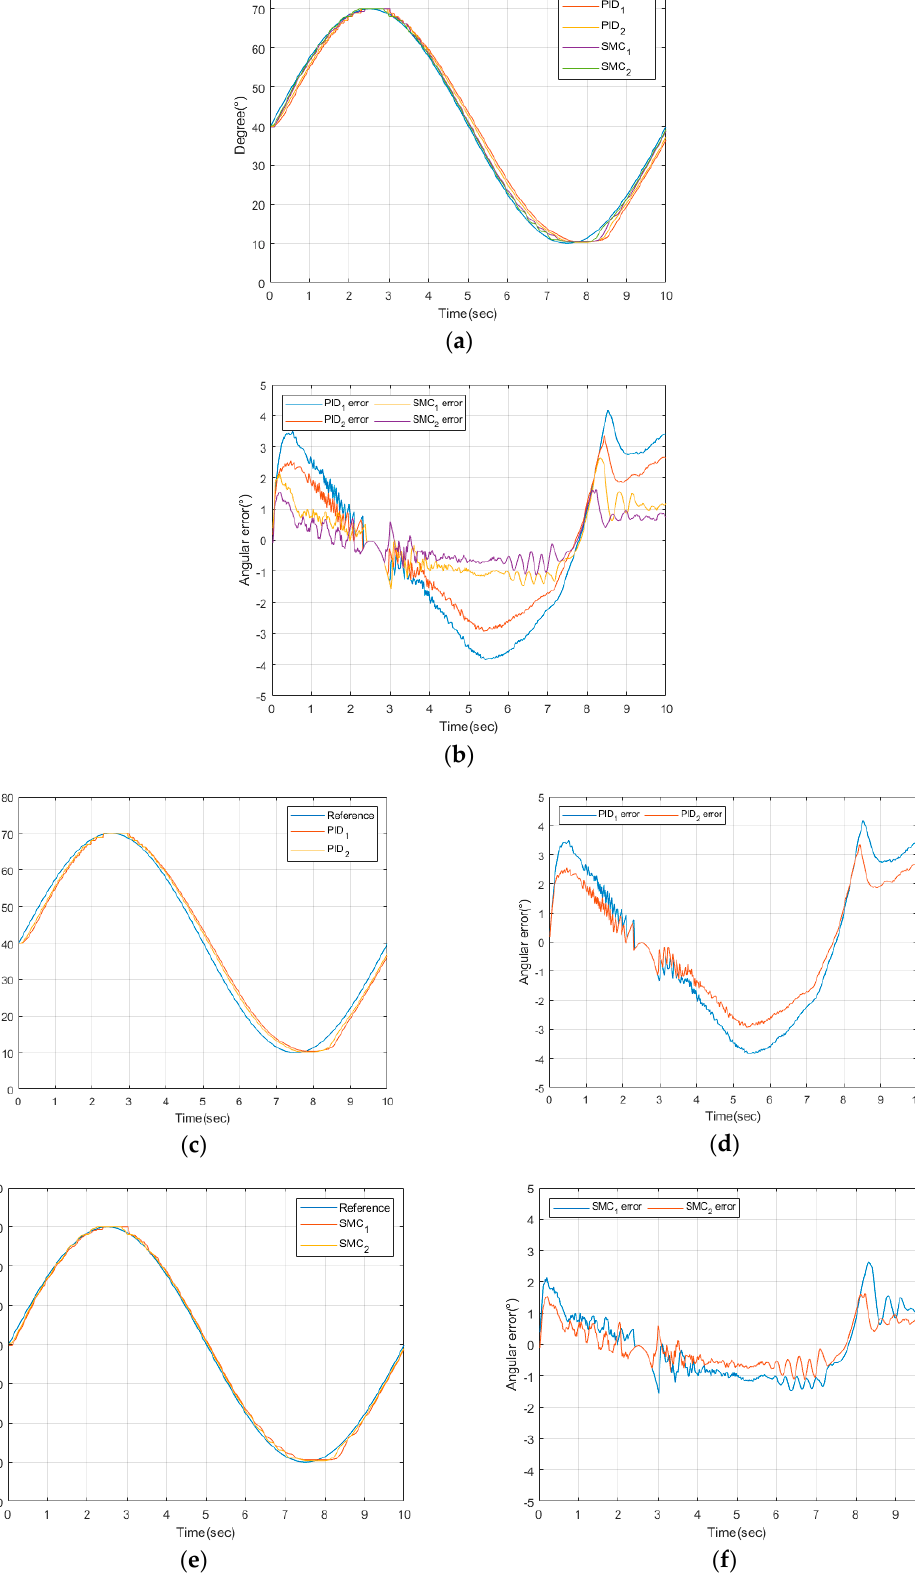
Figure 12. Experimental results of sliding mode control and proportional-integral-differential (PID) control: ( a , c , e ) results of angular position performance; ( b , d , f ) angle tracking error.